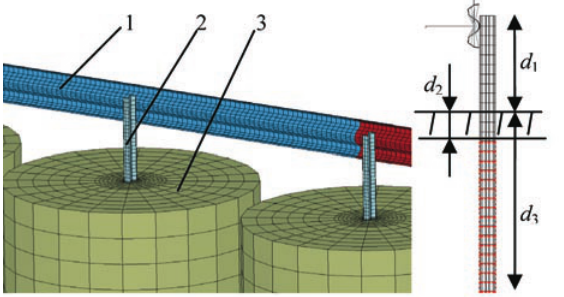
Fig. 4. FEMs of the road safety barrier: 1 – rails; 2 – sigma posts; 3 – soil; d 1 = 700 mm, d 2 = 200 mm, d 3 = 1200